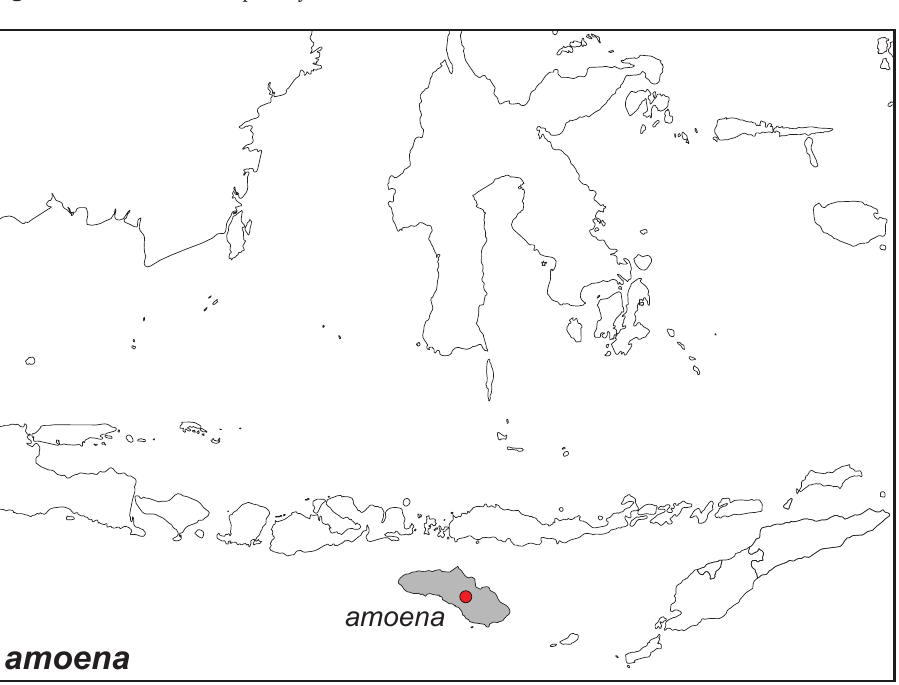
Figure 58. Distribution map of Elymnias amoena